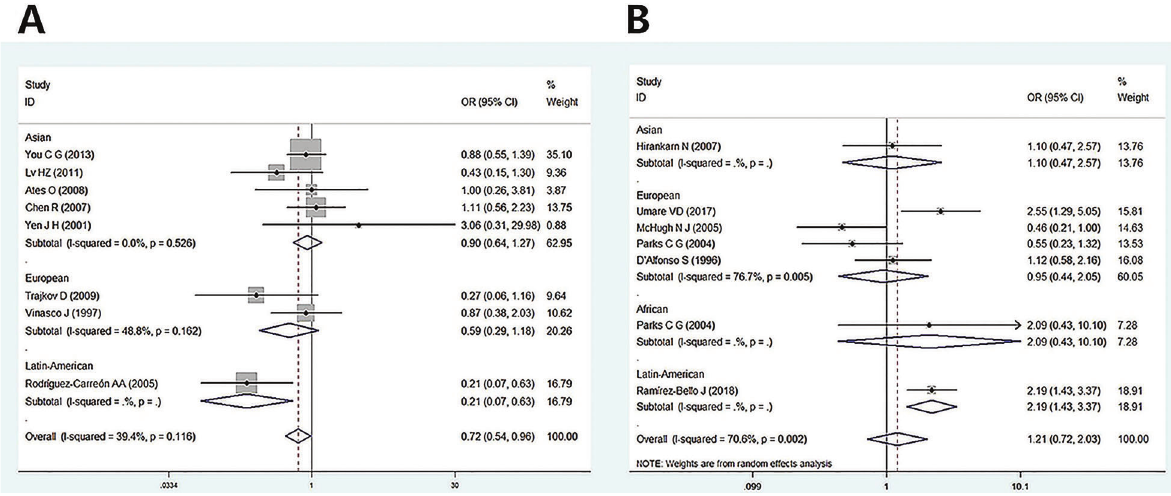
Figure 2. Forest plot for the correlation between TNF- a -238 and rheumatoid arthritis (A) and systemic lupus erythematosus (B)